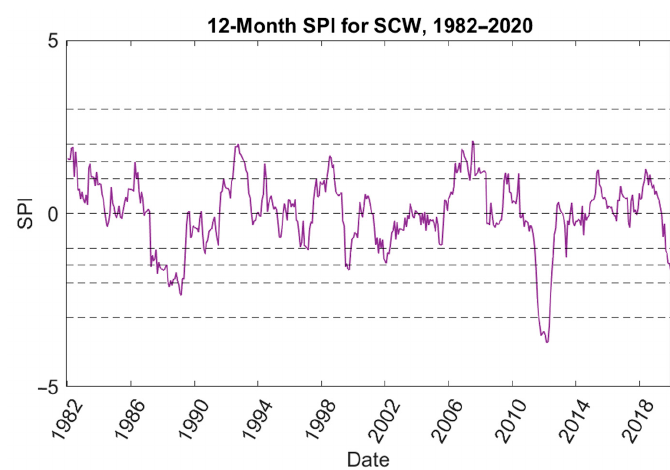
Hydrology 2023 , 10 , x FOR PEER REVIEW Figure A7. 6 ‐ Month SPI from 1982 to 2020. Figure A7. 6-Month SPI from 1982 to 2020.